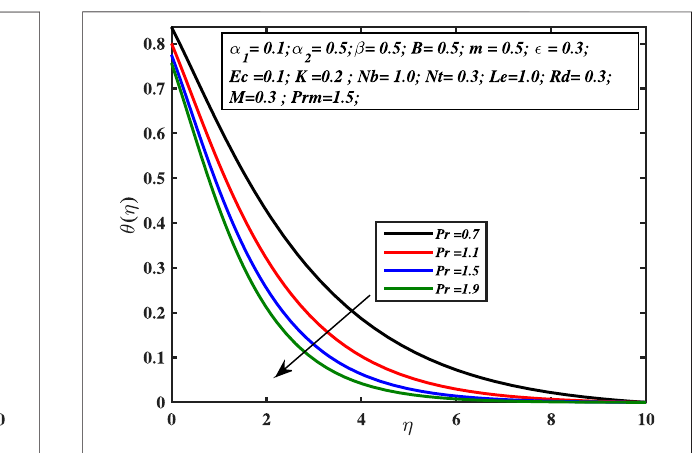
FIGURE 8 | Impact of Pr on the θ ( η ) curve.